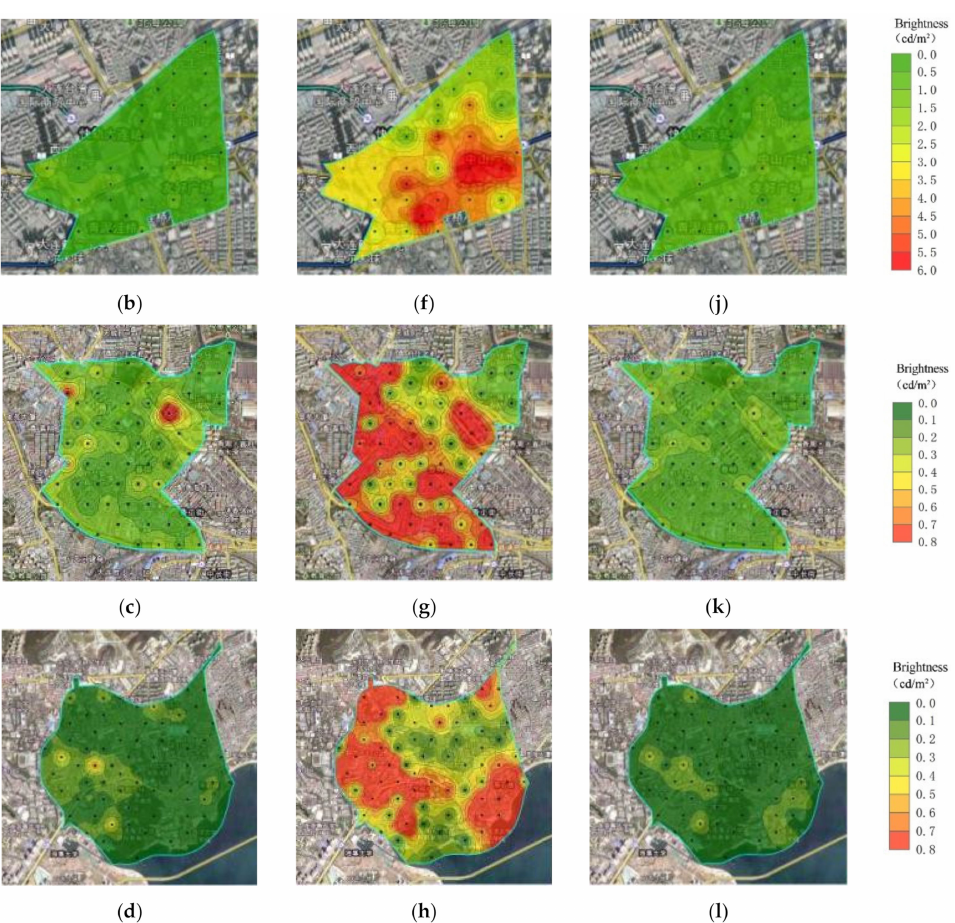
Figure 9. Brightness distribution in three directions of high value area. ( a ) Xinghaiwan upper window; ( b ) Qingniwa upper window; ( c ) Chunliu upper window; ( d ) Heishijiao upper window; ( e ) Xing- haiwan horizontal window; ( f ) Qingniwa horizontal window; ( g ) Chunliu horizontal window; ( h ) Heishijiao horizontal window; ( i ) Xinghaiwan lower window; ( j ) Qingniwa lower window; ( k ) Chunliu lower window; ( l ) Heishijiao lower